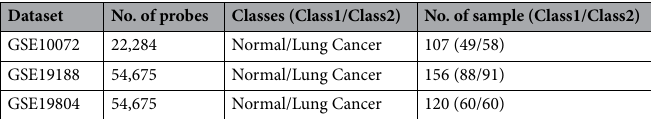
Table 4. Three publicly available lung cancer gene expression datasets.